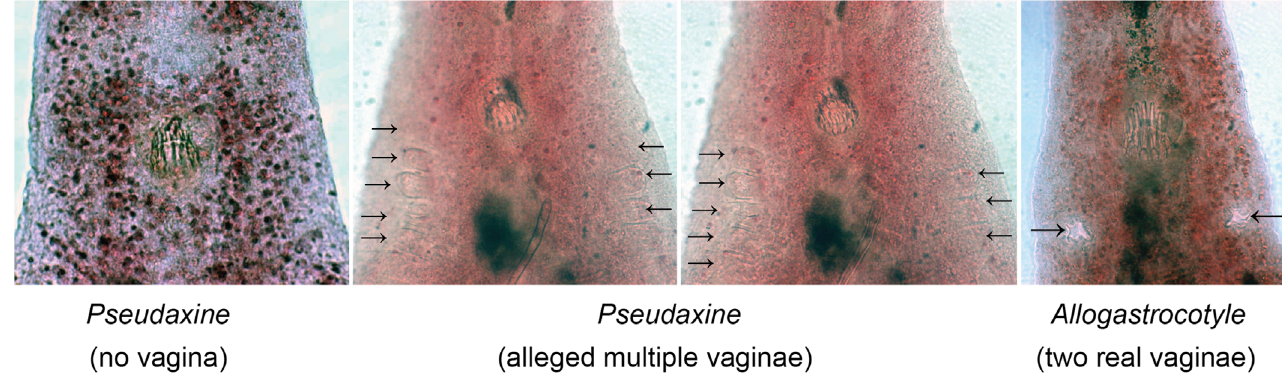
Figure 5. Micrographs of specimens showing the region of the genital atrium and vaginae (arrows). Left, Pseudaxine trachuri , no vagina visible; Middle, Pseudaxine trachuri , alleged multiple vaginae, two different focuses on the same specimen; Right, Allogastrocotyle bivaginalis , two real vaginae. Unscaled, same scale for all micrographs. Table 3. Hosts and localities of Pseudaxine trachuri from the literature. Order: type-host fi rst, then other species of Trachurus , then other species in alphabetical order. For Boops boops , the compilation by Pérez-del Olmo [65] includes many previous